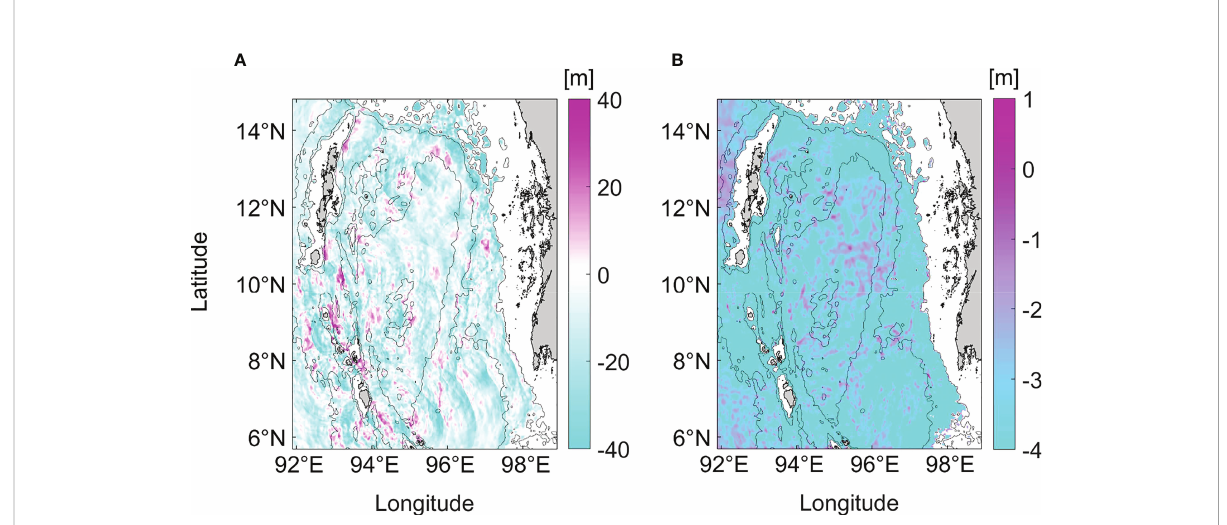
FIGURE 8 A snapshot of the model-predicted isothermal displacements of 18°C for (A) semidiurnal internal tides and (B) diurnal internal tides at 00:00 on 18 March 2006. Bathymetry contours are spaced at 100, 500, and 2000 m. The blank space represents the shelf. Note that the color scales in the two panels are